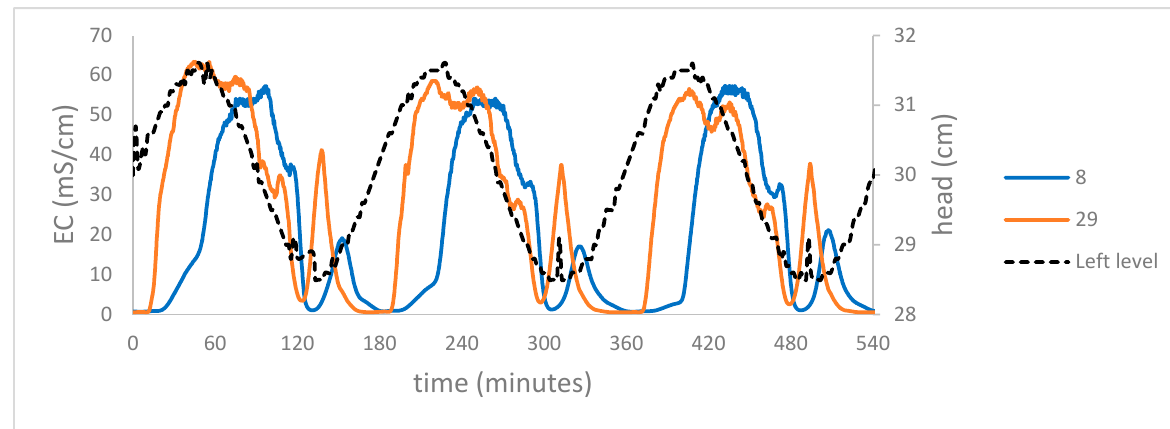
Figure 5. Head oscillation at the left boundary and electrical conductivity variation of groundwater at two sensors during E3-180. Sensor locations are shown in Figure 4a.